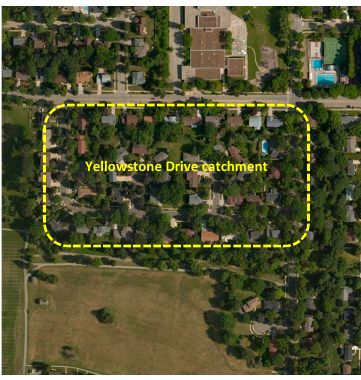
Figure 9. Yellowstone Drive catchment (WI)